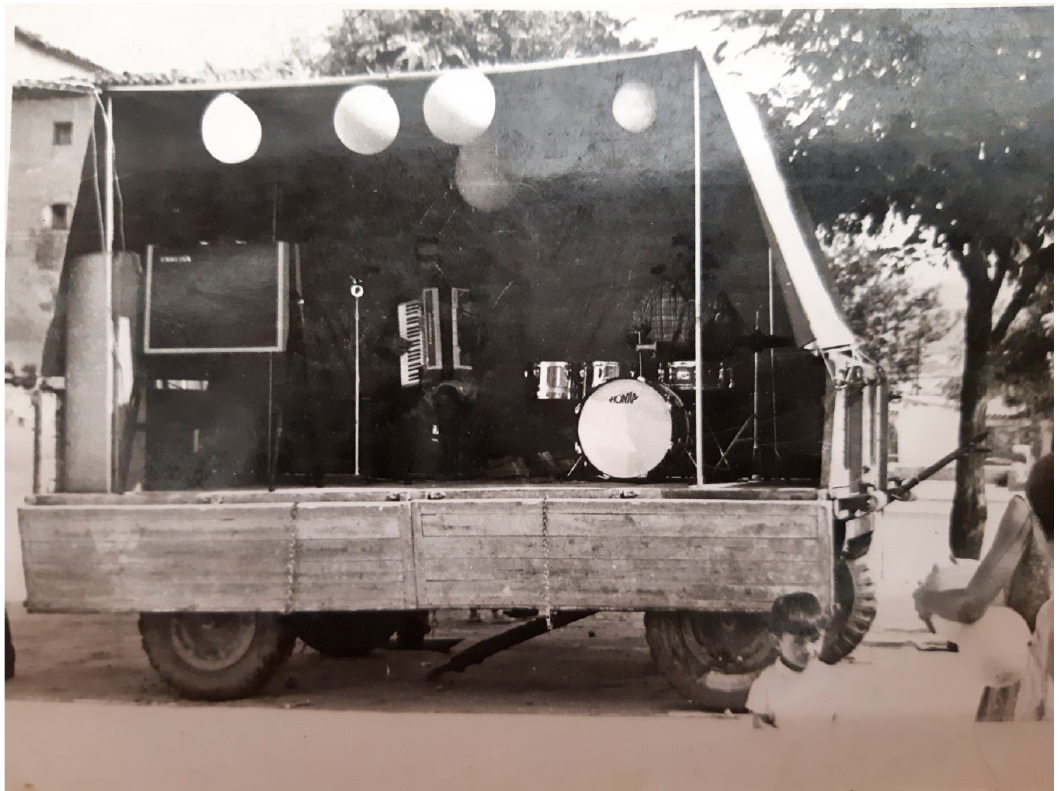
Figure 4. An orchestra adding splendor to the afternoons during feasts. It played on a trailer in which grain or other crops were transported. Source: Private Archive of Carmelo San Martin.